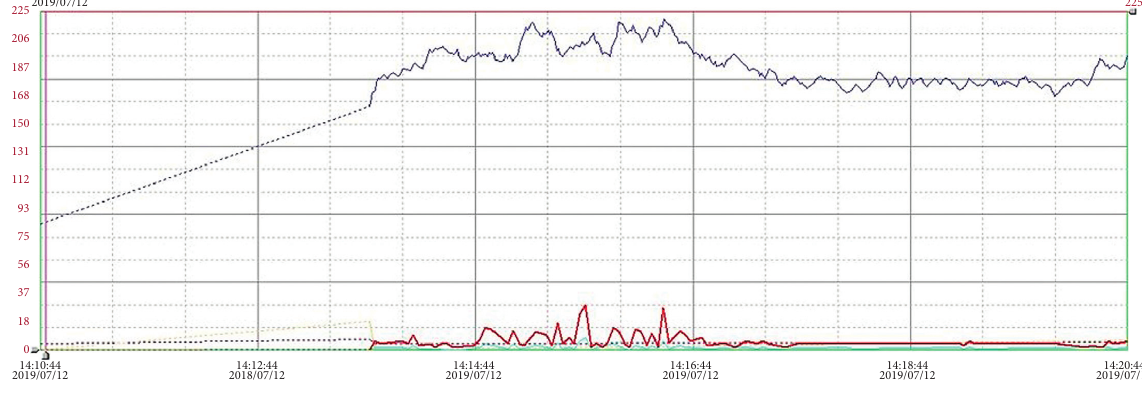
Figure 18: Cutting power. Table 5: Force of the cutting